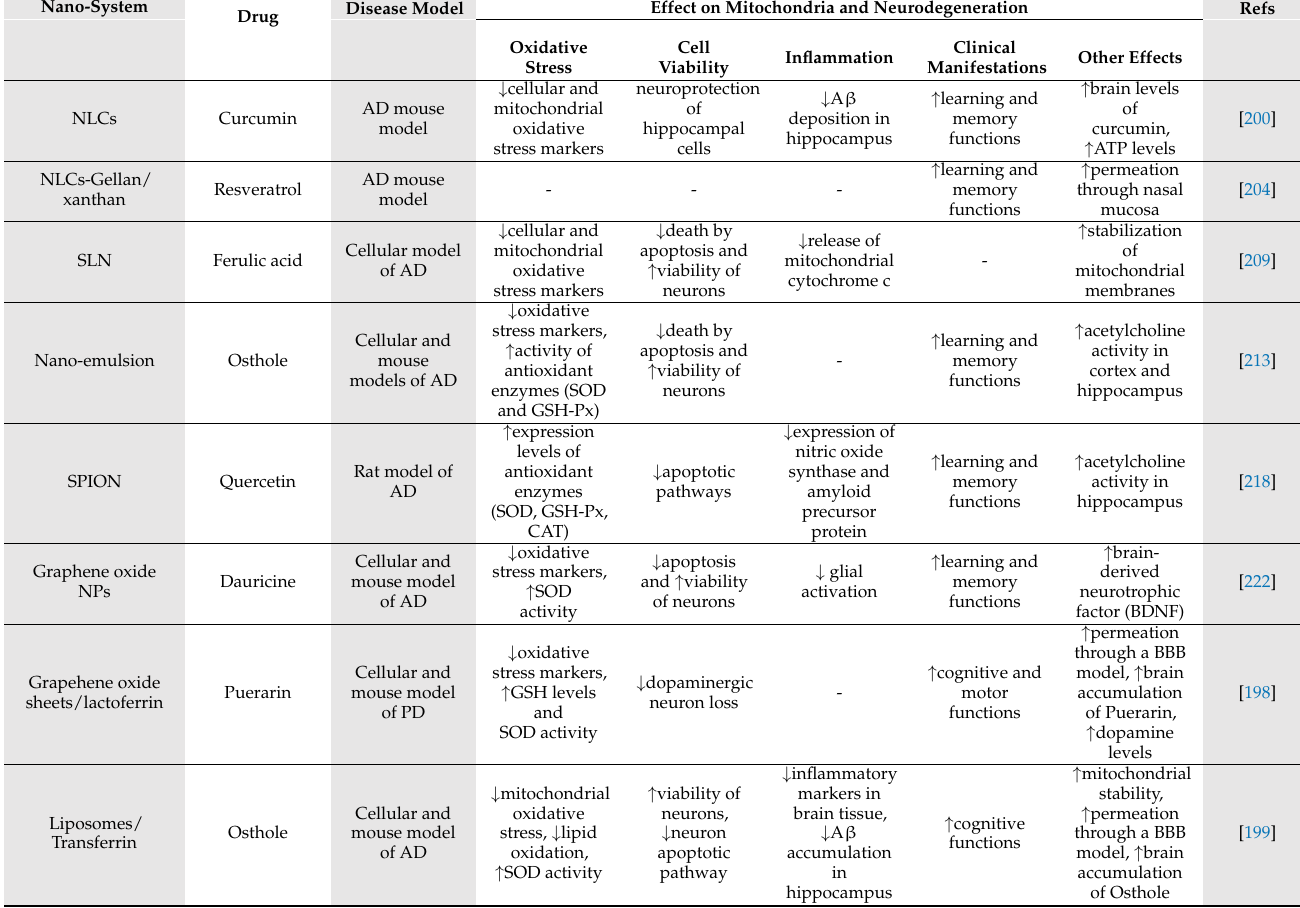
Table 3. Nanosystems containing antioxidant and neuroprotective plant chemicals to repair mitochondrial function in models of neurodegenerative